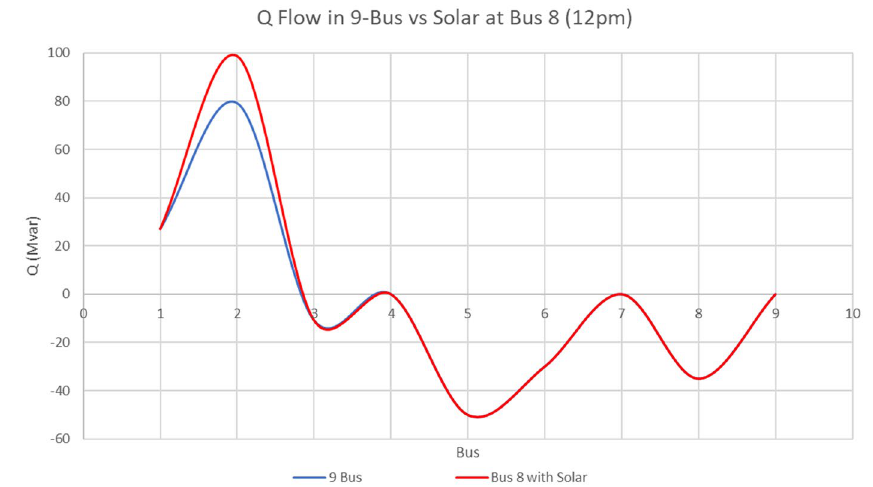
Fig. 10 Reactive power flow of IEEE-9 bus versus solar bus placed at bus 8